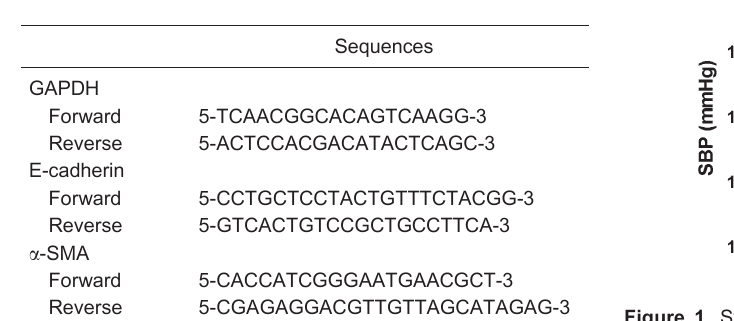
Table 1. Primers used in real-time PCR experiments.